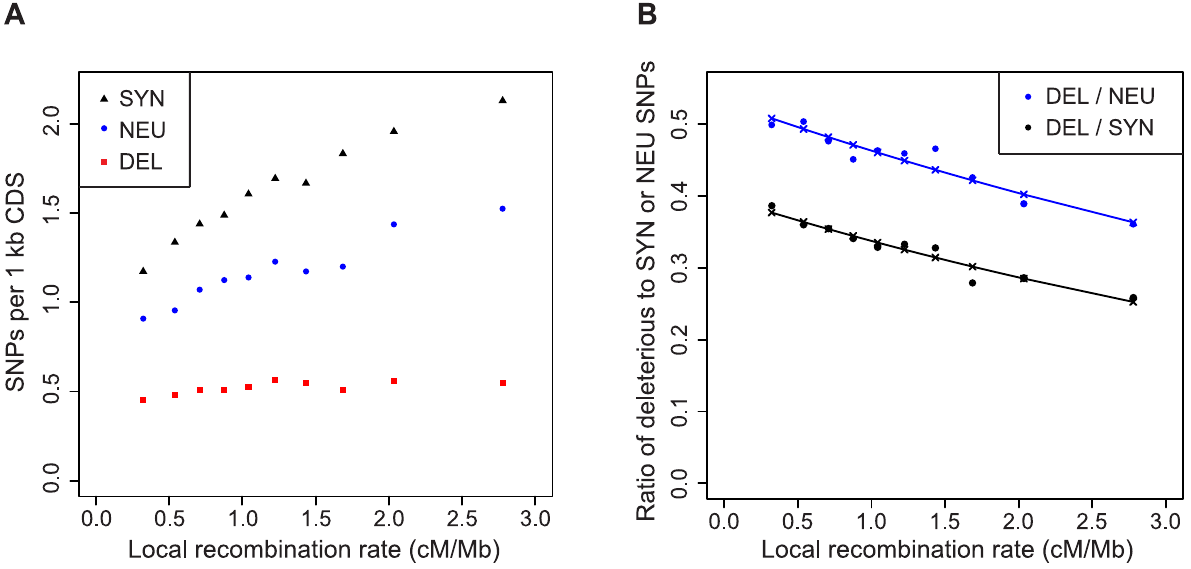
Figure 2. Regions of low recombination are enriched for deleterious SNPs. The number of synonymous (SYN) and neutral nonsynonymous (NEU) and deleterious (DEL) SNPs per kb of coding sequence (A) and the ratio of deleterious to synonymous or neutral nonsynonymous SNPs (B) as a function of the local recombination rate. The rate of neutral and deleterious SNPs was normalized by the number of sites that were testable by the likelihood ratio test. Lines show the results of logistic regression.